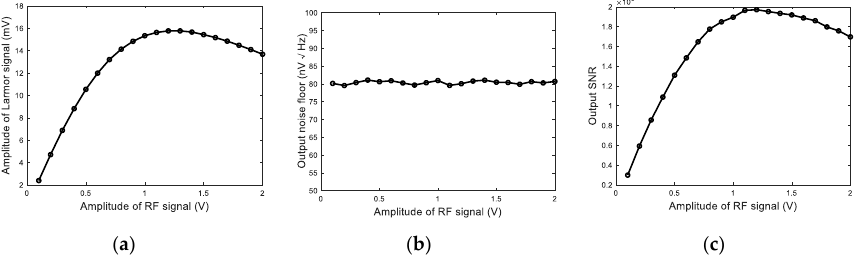
Figure 11. The measured amplitude of the Larmor signal, the output noise floor and the output signal-to-noise ratio (SNR) varying with the amplitude of RF signal. ( a ) The measured amplitude of the Larmor signal. ( b ) The output noise floor. ( c ) The output